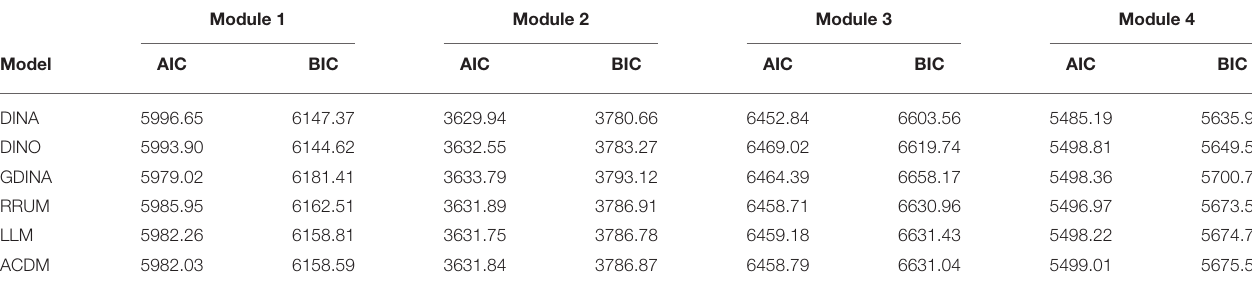
TABLE 5 | Model-data fit indices.